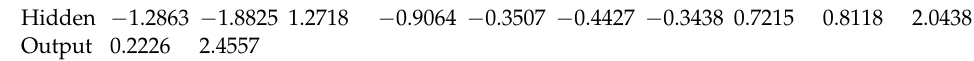
Table 5. Bias to hidden and output layers.